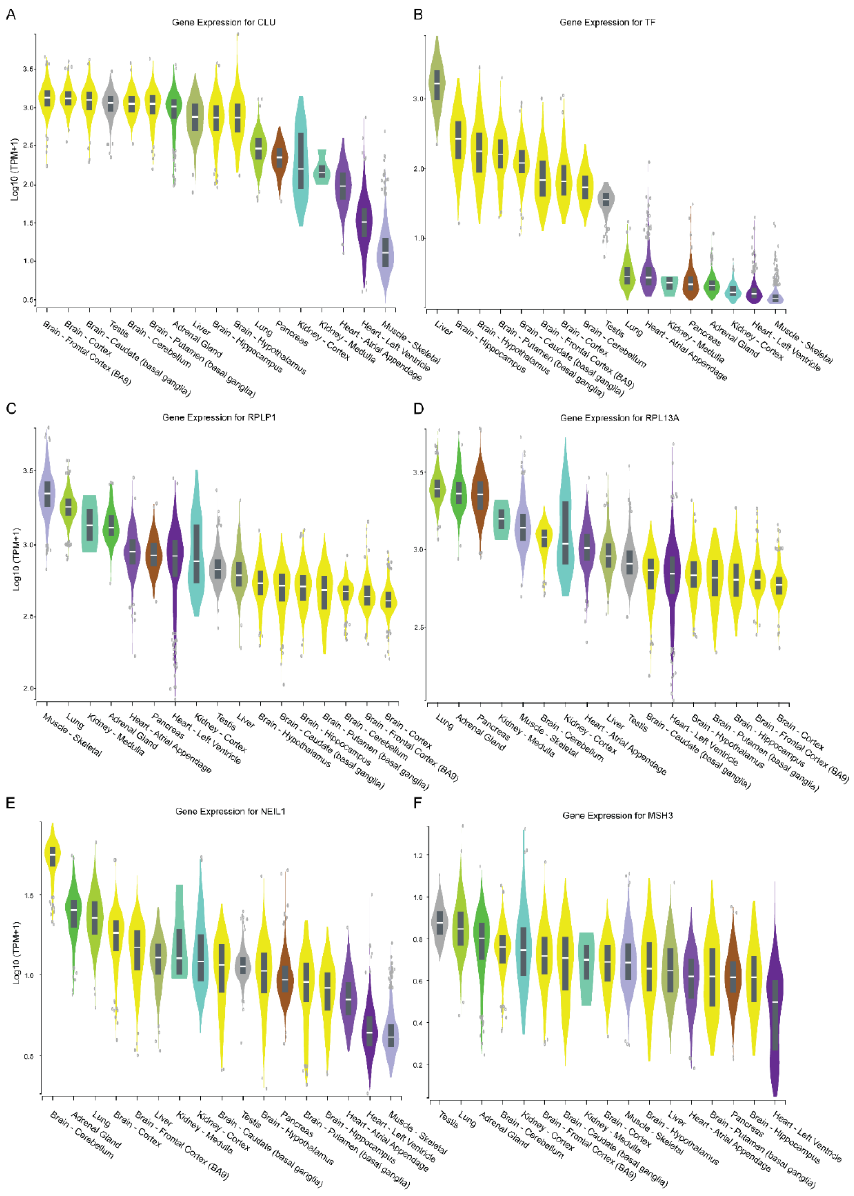
Figure 5. The genotype-tissue expression (GTEx) profile of the selected genes from the organs used in this study. Among tissues with high CAG repeat instability (liver, testis, caudate, and putamen), a list of 100 genes highly expressed in each organ was analyzed on the GTEx database. Among 35 genes in all four tissue samples, genes showing a similar trend as the CAG instability were selected for further analysis ( CLU , TF , RPLP1 , and RPL13A ). ( A , B ) CLU and TF expression showed a similar trend as the expansion index where liver, testis, and brain showed a high gene expression while muscle and heart showed a low gene expression. ( C , D ) RPLP1 and RPL13A showed the opposite trend as the expansion index. ( E , F ) Among the genes associated with CAG expansion, NEIL1 and MSH3 gene expressions were plotted.